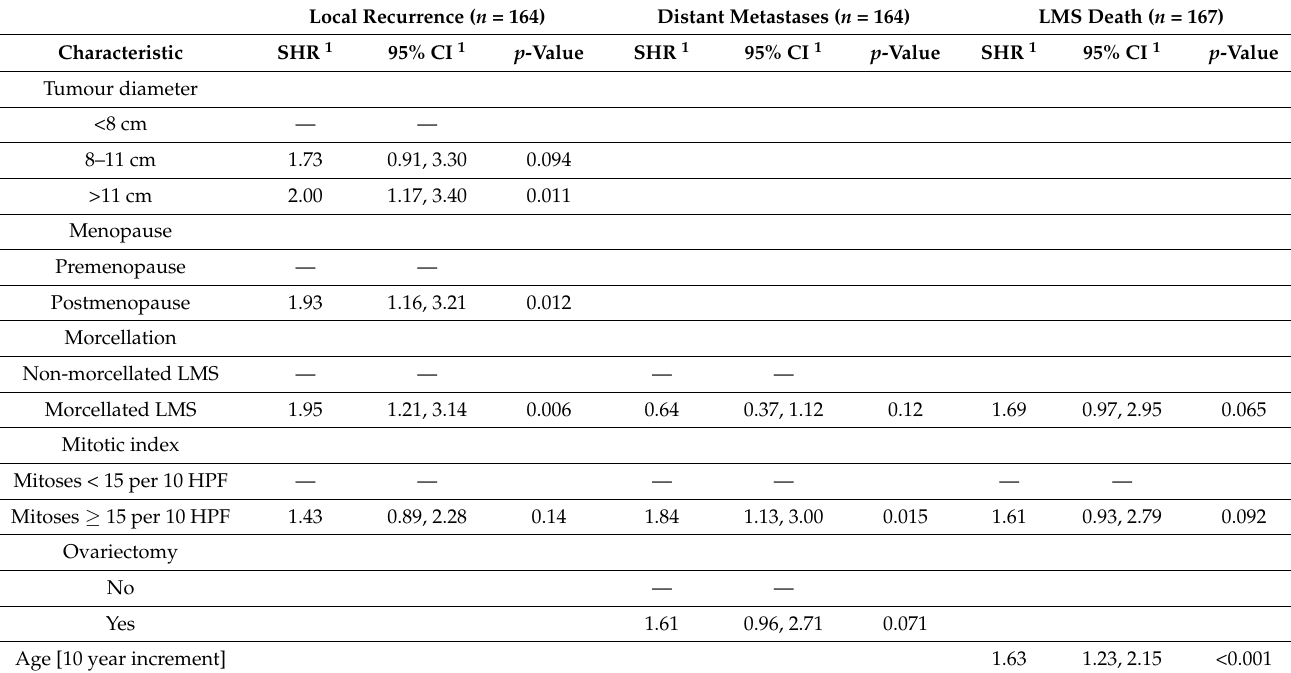
Table 4. Results of the multivariable competing risks regression of pT1 LMS including mitoses counts after stepwise model reduction showing the subdistribution hazard ratios (SHR) of each factor with 95%-confidence intervals for each event type